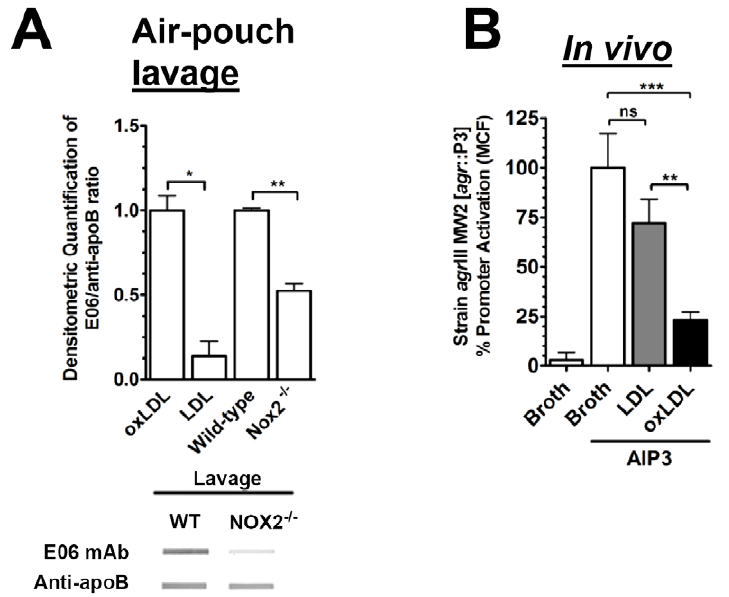
Figure 5. Exogenous oxLDL restores in vivo antagonism of agr III-signaling. (A) Control LDL and oxLDL plus air-pouch lavage from MW2 infected wild-type and Nox2 2 / 2 mice was vacuum transferred to nitrocellulose and stained for oxLDL using monoclonal antibody E06 or rabbit polyclonal antibody to apoB. A representative blot is shown. Band intensity was quantified using Carestream Molecular Imaging software (New Haven, Connecticut), and data normalized to oxLDL or wild-type lavage with E06/apoB ratios equal to 1. (B) Air-pouches were generated on the backs of 8 to 12 week old Nox2 2 / 2 mice treated with 4APP as previously described. At time zero, 4 6 10 7 cfu of early exponential phase agr III isolate MW2 [ agr ::P3-yfp] were injected into the air-pouch along with saline control or the following as indicated: 100 nM AIP3 and either buffer control, 100 nM LDL or 100 nM oxLDL. After 4 h pouches were lavaged and agr ::P3 promoter activation assessed by flow cytometry. Data reported are the mean 6 SEM normalized to PBS/AIP3 control. ns, not significant; *, p , 0.05; **, p , 0.01; ***, p ,